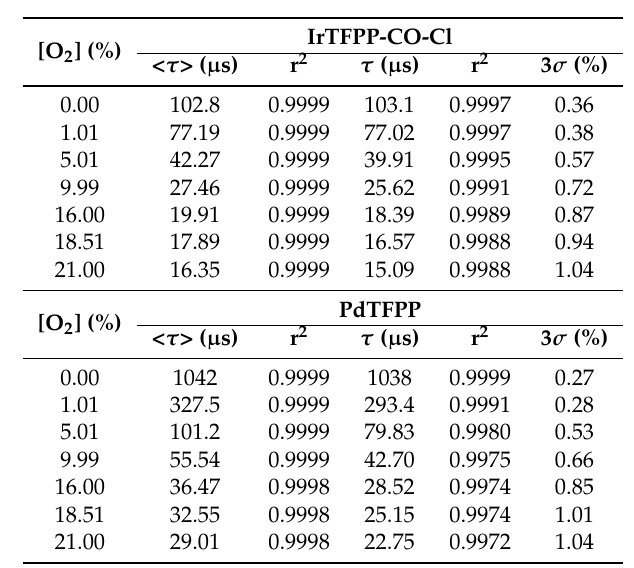
Table 2. Measured lifetimes a , coefficients of determination (r 2 b ) and uncertainties (3 σ c ) for the indicators in